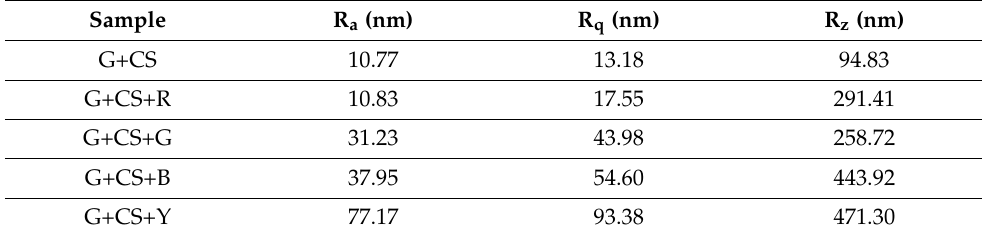
Table 2. Comparison of R a , R q , and Z values obtained from AFM images of different